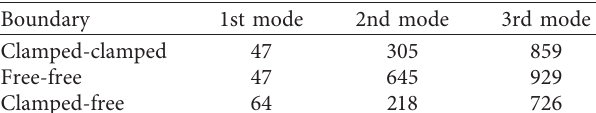
Figure 9: Characteristic curves of natural frequency of out-of-plane vibration for the curved beam, (a) clamped-clamped boundary, (b) free- free boundary, and (c) clamped-free boundary. Table 2: Natural frequencies (Hz) with clamped-clamped and free- free boundaries for the single model.